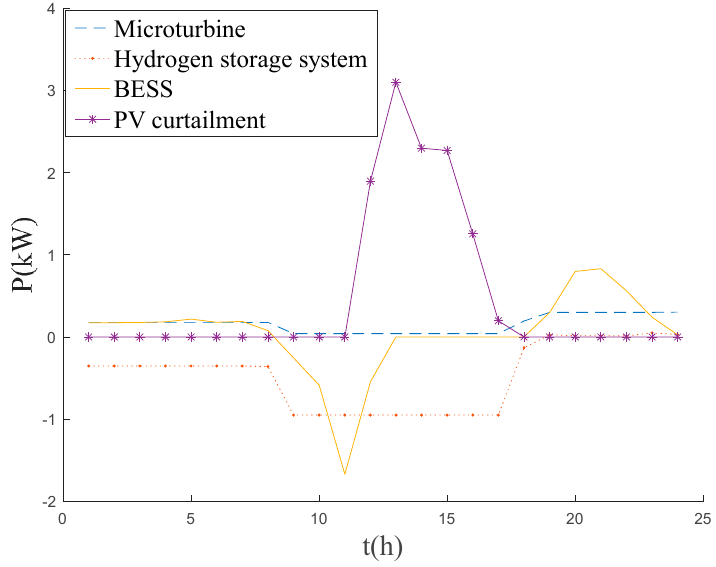
Figure 12. Scheduling results of microgrid using method 2.